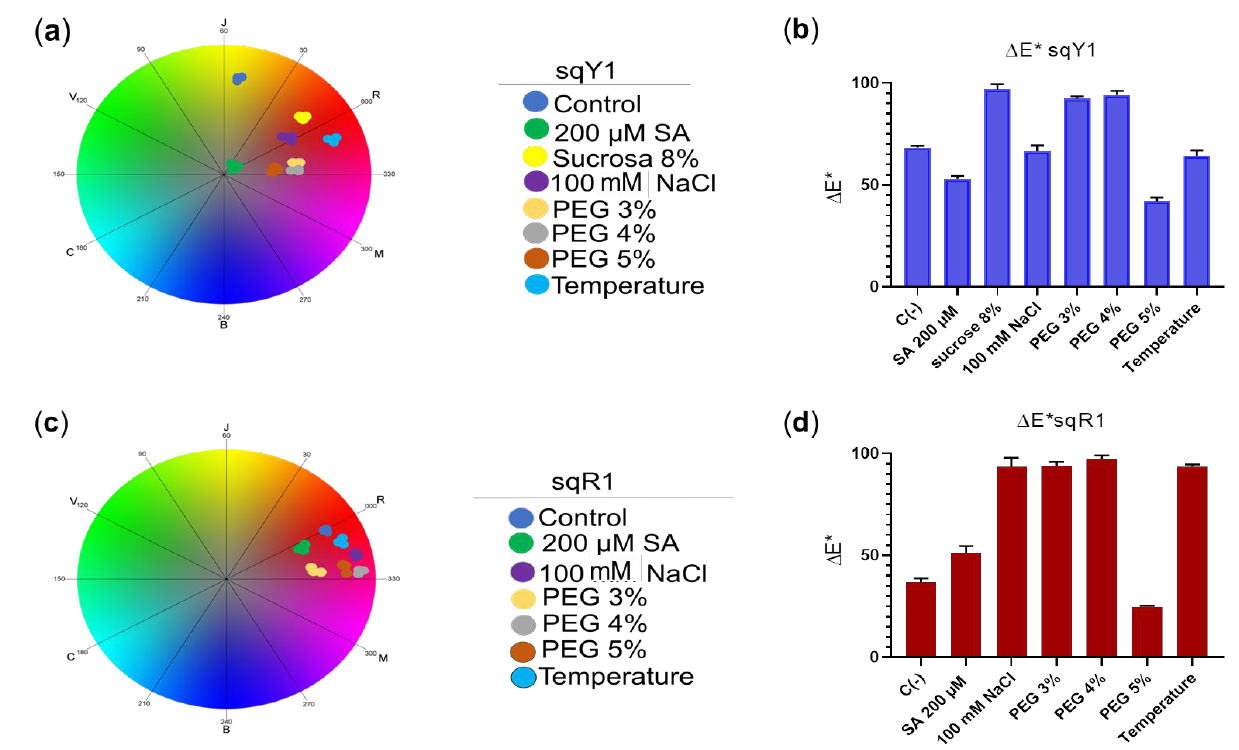
Figure 7. Analysis of color change in sqY1 and sqR1 lines under different types of stress. ( a ) Coordinates in the chromatic circle of CIELab space for the sqY1 line and ( c ) for sqR1, circles correspond to three replicates per treatment. ( b , d ) Bar graph shows the average color difference for each treatment in sqY1 and sqY2, respectably. Bars indicate standard deviation with three independents replicates.